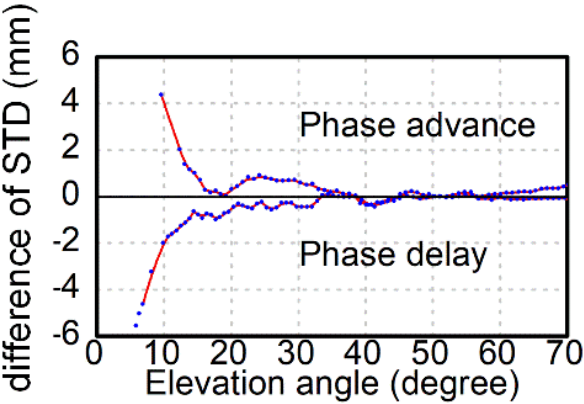
Figure 13. The impacts of HOI effect on slant tropospheric delay (STD) ( left ) and the sky plot of PRN 28 ( right ) for station MAUI on DOY 249 in 2017. The phase advance and phase delay are separated by a black